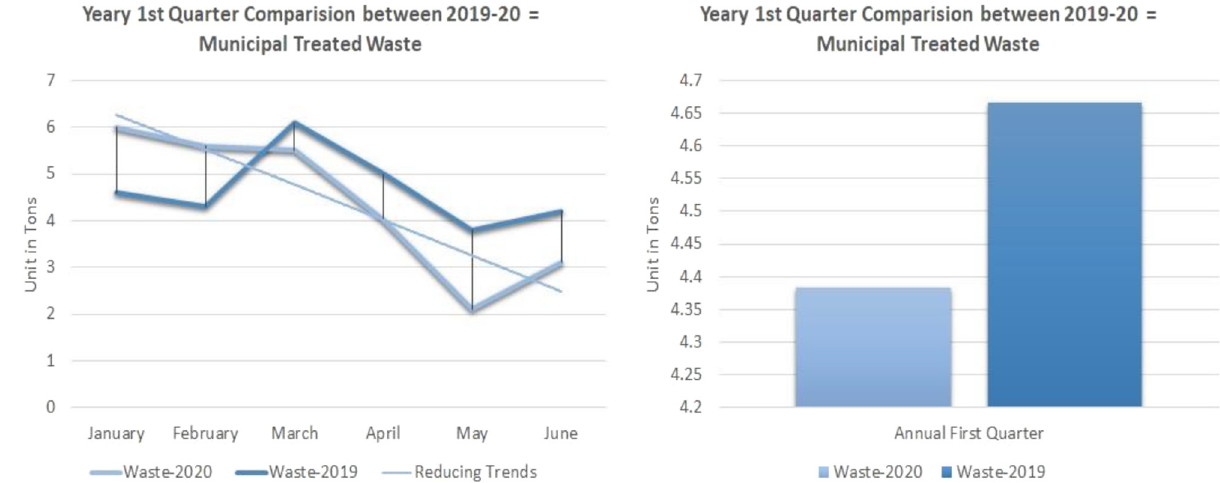
Fig. 11. Municipal treated waste 2019 – 2020 (Ajman (cid:1) UAE)